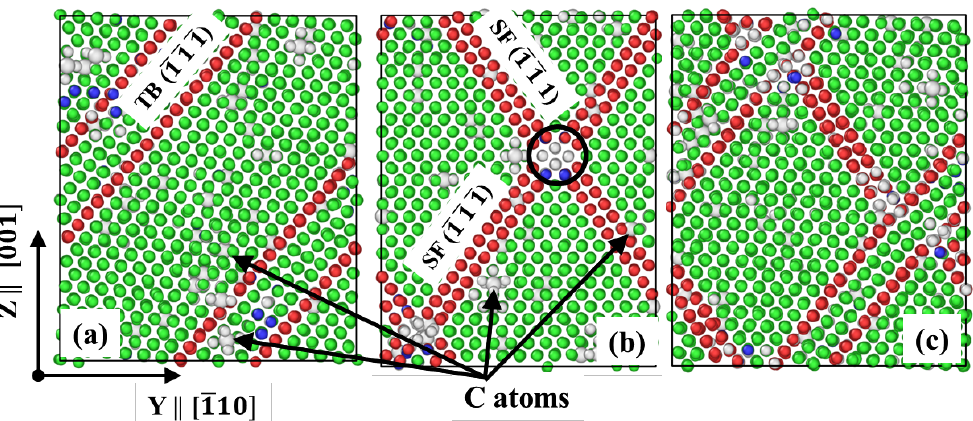
Figure 1. The three defect configurations in the fcc phase of Fe-0.5 at. %C ( a ) parallel twin boundaries (TB), ( b ) Intersecting stacking faults (SF), and ( c ) Intersecting SF and TB. Atoms are coloured as per adaptive-common neighbour analysis (a-CNA): green—face-centered-cubic (fcc), blue—body-centered-cubic (bcc), red—hcp, and grey—unidentified. The radius of C atoms is increased manually for better